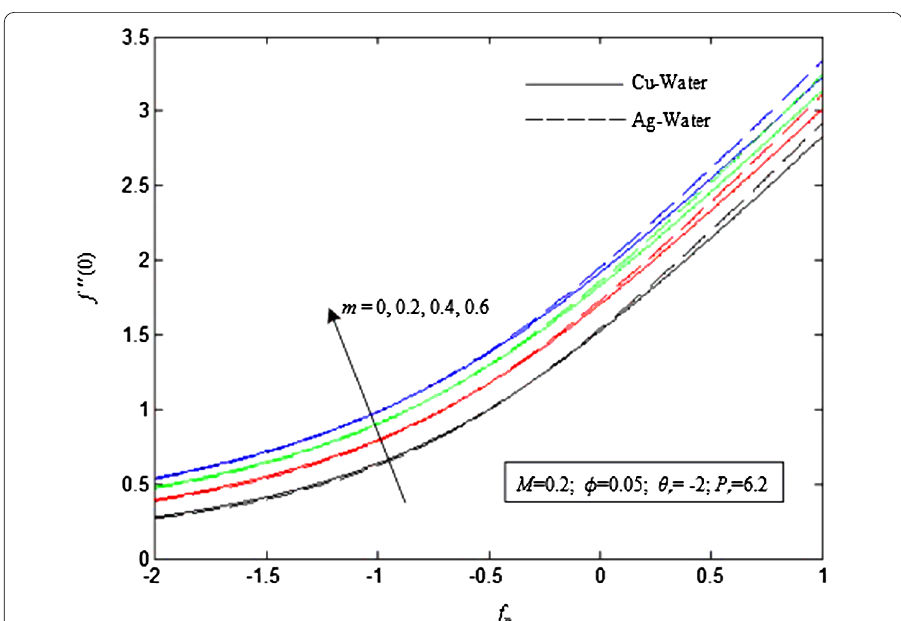
Figure 9 Skin friction coefficient as a function of f w for representative values of m .